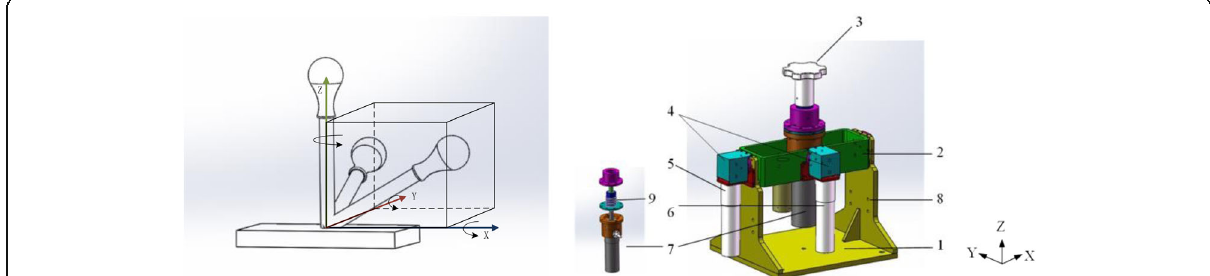
Fig. 1 Assembly drawing of the haptic device. (1) Base. (2) Cuboid frame. (3) Handle. (4) Bevel gears. (5) Y -axis actuator. (6) X -axis actuator. (7) Cylinder sleeve with Z -axis actuator. (8) Mounting holes for restoring rubber bands. (9) Restoring torsion